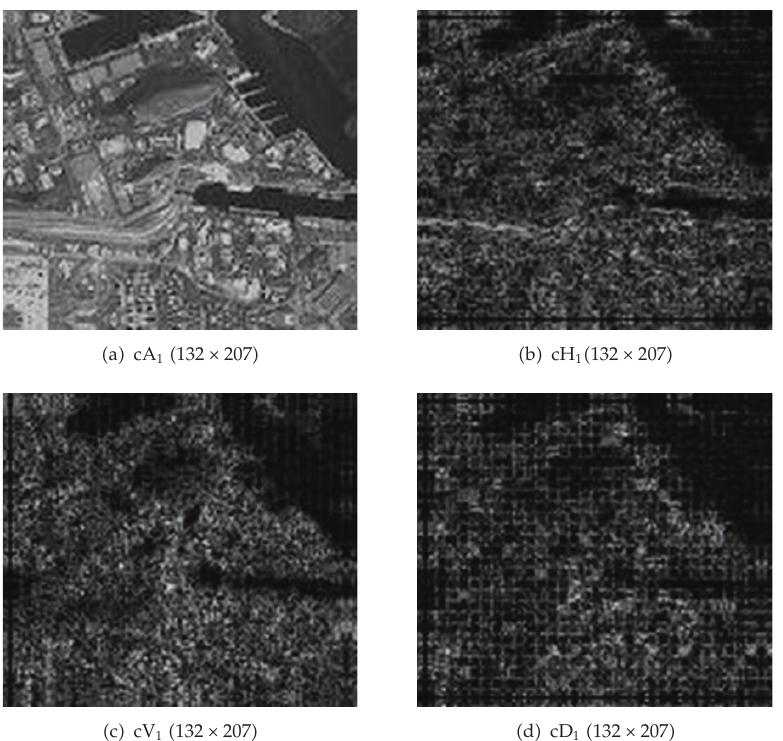
Figure 4: First level decomposition of Image: (cid:3) a (cid:4) approximation coe ffi cients, (cid:3) b (cid:4) horizontal coe ffi cients, (cid:3) c (cid:4) vertical coe ffi cients, (cid:3) d (cid:4) diagonal coe ffi cients.